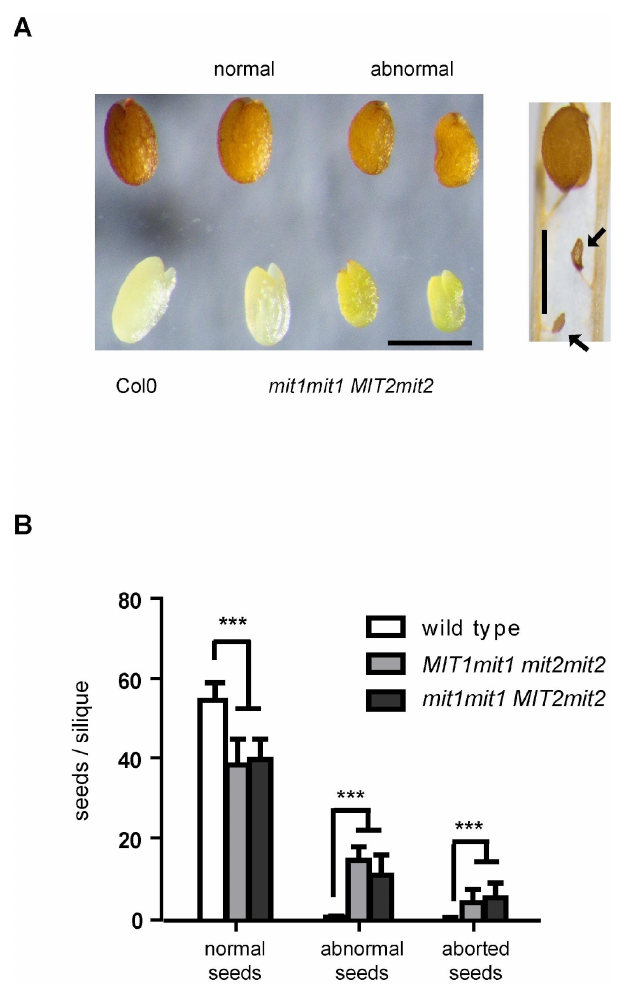
Figure 2. Seed abnormalities in plants carrying three mit mutated alleles. ( A ) Mature seeds and manually extracted embryos from wild type Col0 and mit1mit1 MIT2mit2 plants. “Normal” seeds are those with a wild phenotype; “abnormal” seeds and embryos are somewhat smaller and have an irregular surface. To the right is shown a silique fragment with two shrunken, collapsed seeds, indicated by arrows. Bars = 500 µ m. ( B ) Seed (normal, abnormal, and aborted) set per silique was scored along the main inflorescence for four F3 MIT1mit1 mit2mit2 plants, four F3 mit1mit1MIT2mit2 plants, and two wild type plants. Twelve siliques per plant (from the 5th to 16th in appearance) were scored. Error bars are SD. Asterisks indicate values that were determined by the t ‐ test to be significantly different from wild type (***, p < 0.001).